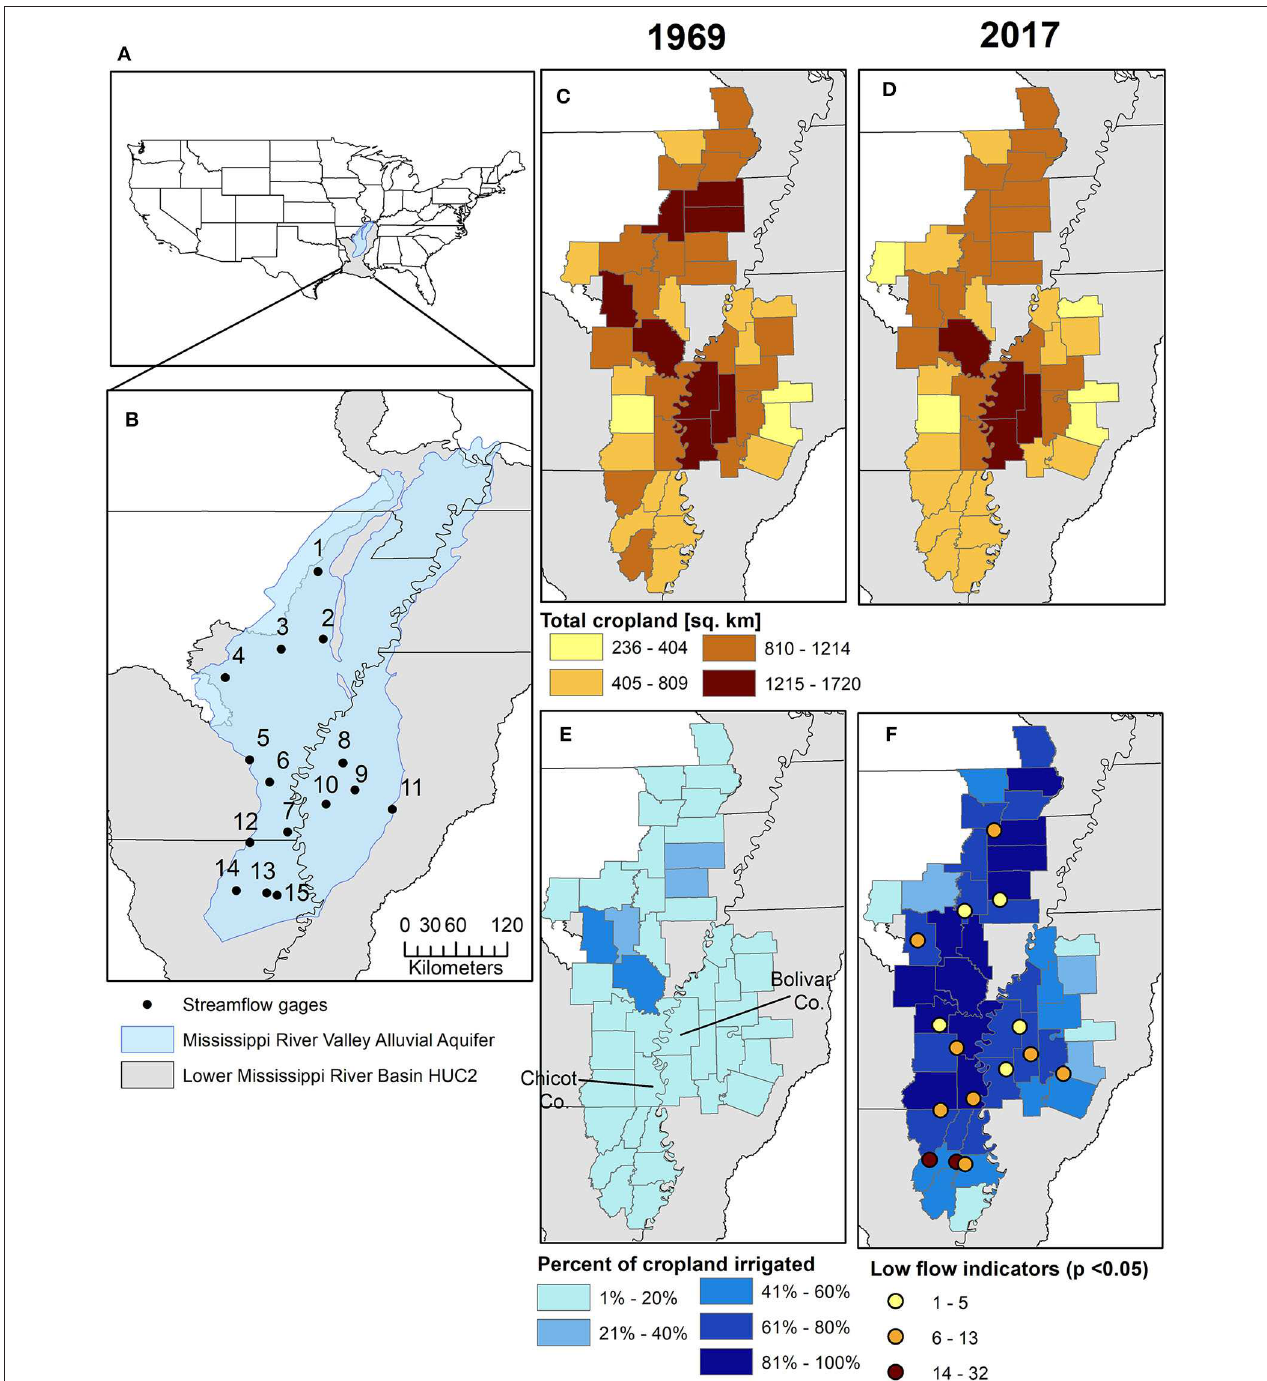
FIGURE 2 | (A) Location of Mississippi Alluvial Plain within the United States; (B) location of gauge locations within Mississippi Alluvial Plain and Lower Mississippi River Basin, numbers correspond to gauge information in Table 1 ; (C) harvested cropland by county and parish in 1969; (D) and 2017; (E) percent of cropland with irrigation in counties and parishes in 1969; (F) and 2017 with the color of USGS representing the number of low flow indicators with a statistically significant increasing trend. increase from 2007 to 2017. Cotton declined from 1992 to 2012, while harvested corn increased during the same time frame.